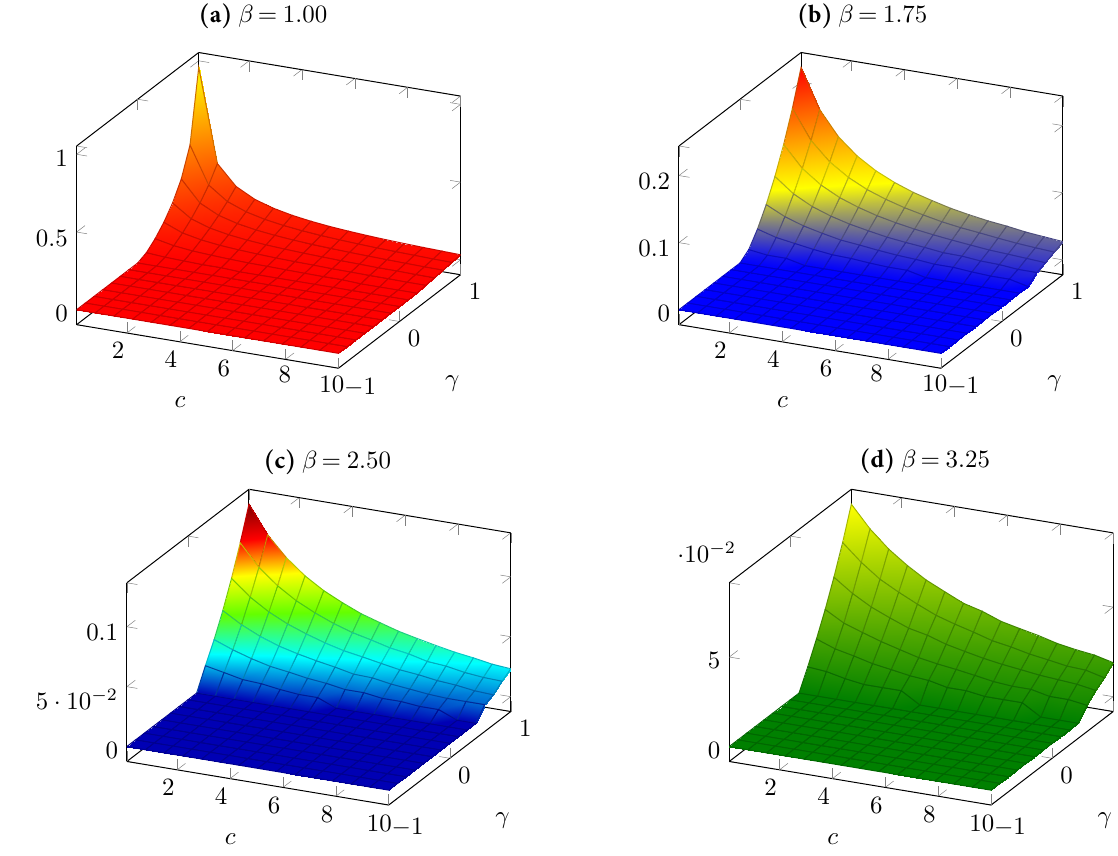
Figure 3. Plots of ¯ η for various values of β , γ , and c . 309